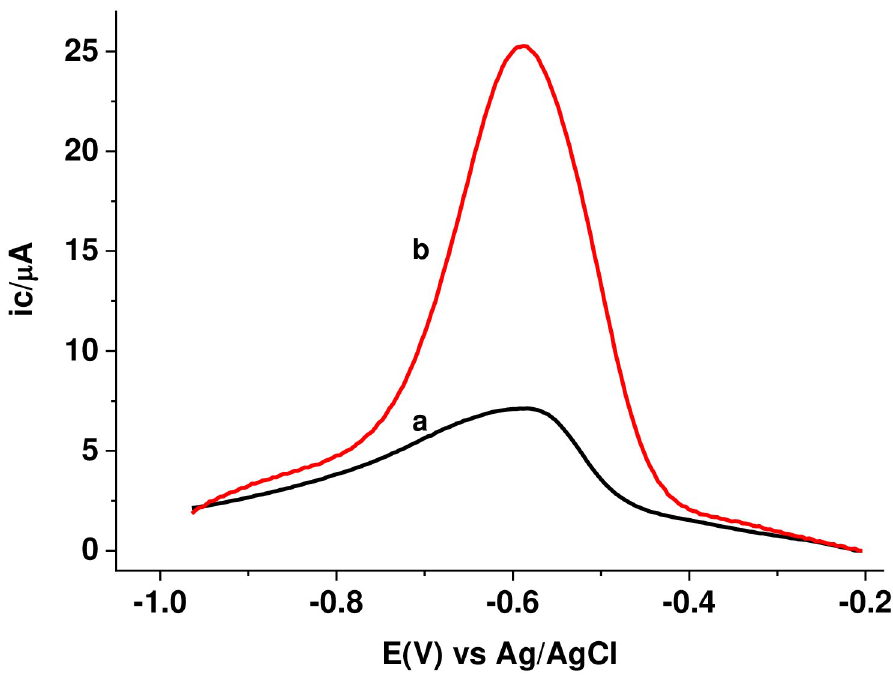
Fig 11. SWAdCSV of EPHARM MTZ sample in PBS pH 7.0 spiked with 50 μ M of standard MTZ.